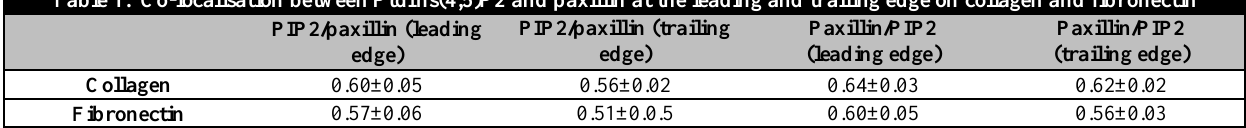
Table 1. Co-localisation between PtdIns(4,5)P2 and paxillin at the leading and trailing edge on collagen and fibronectin PIP2/paxillin (trailing PIP2/paxillin (leading edge) edge) Collagen 0.60±0.05 Values are expressed as mean±SD.